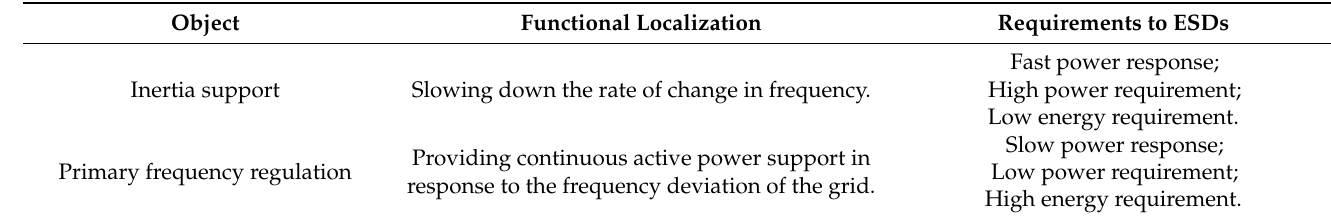
Table 5. The difference between inertia support and primary frequency